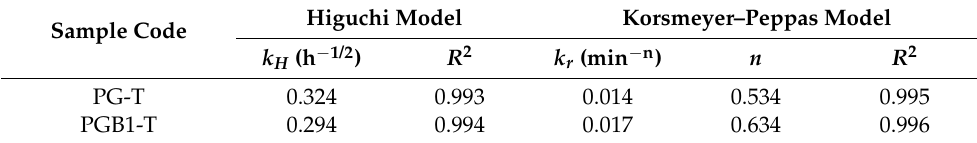
Table 6. Kinetic parameters of 1,2,4-triazole release from PG-T and PGB1-T systems. Sample Code